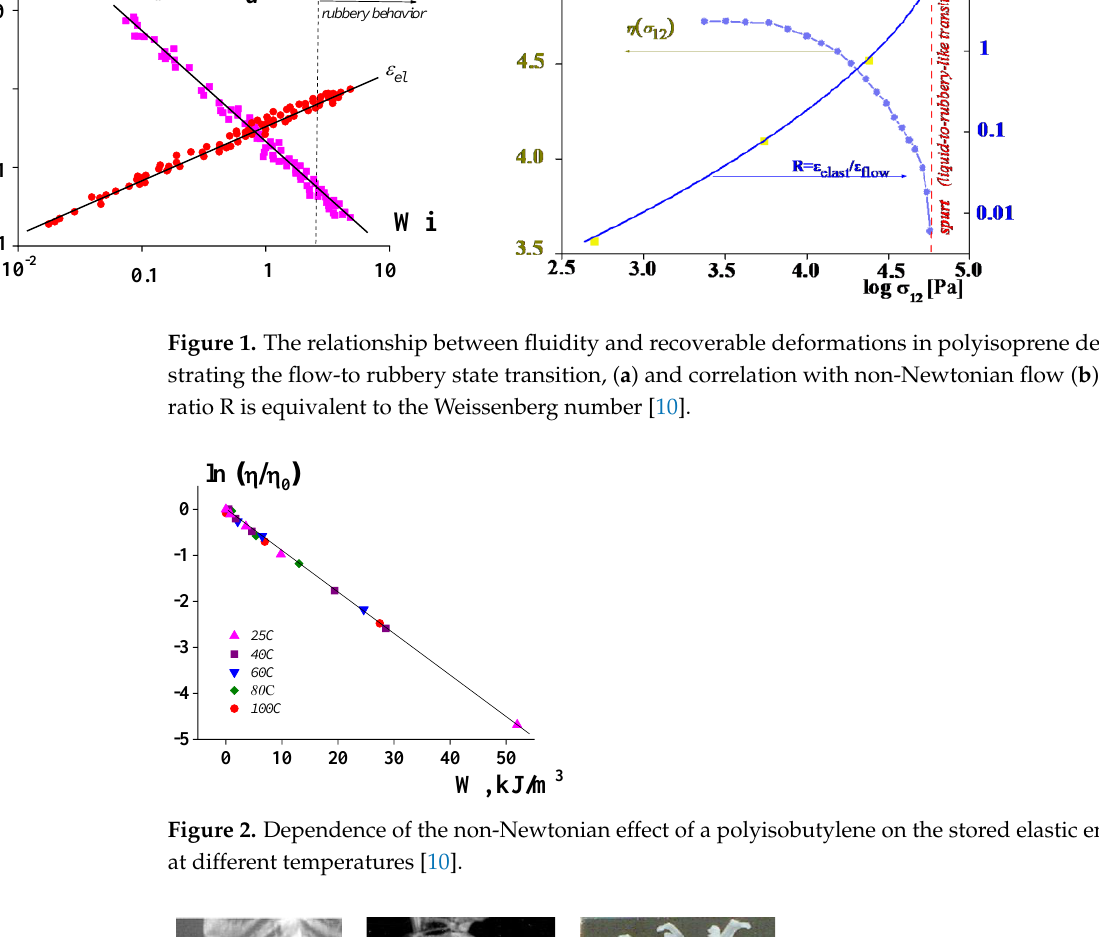
Figure 2. Dependence of the non-Newtonian effect of a polyisobutylene on the stored elastic energy at different temperatures [10].